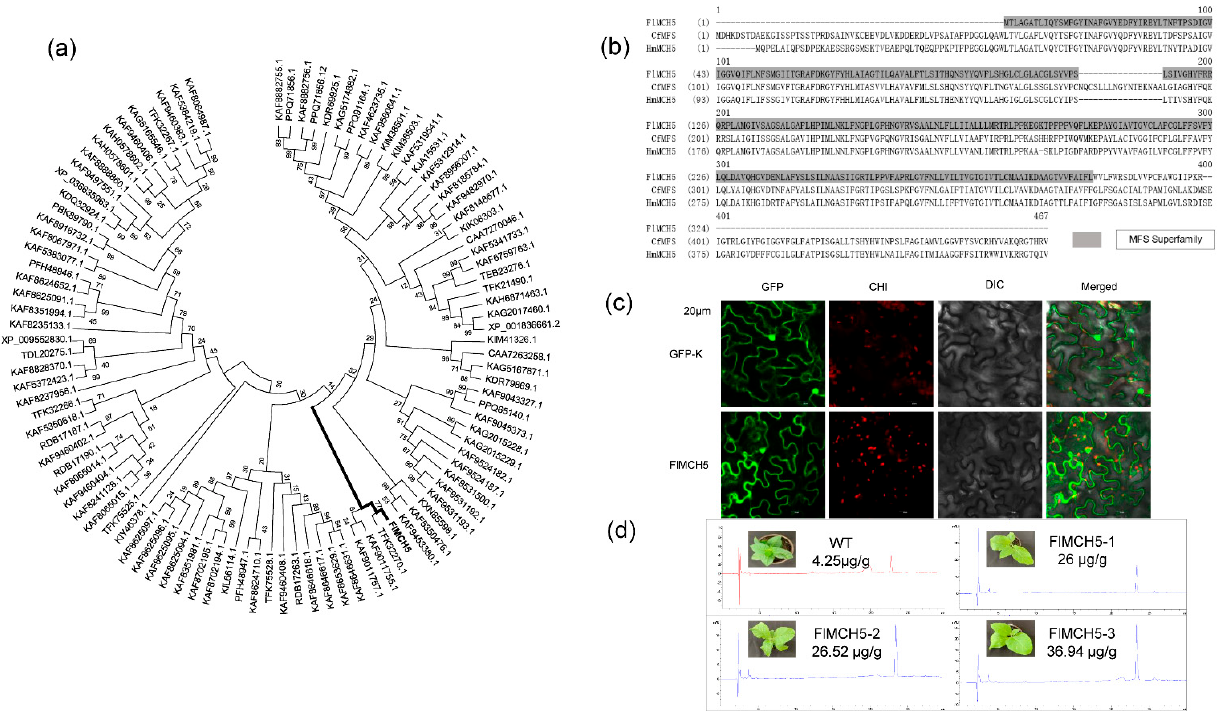
Figure 3. Functional analysis of FlMCH5. ( a ) Phylogenetic tree analysis of FlMCH5. ( b ) FlMCH5 structural–functional domain comparison, where gray represents MFS superfamily. ( c ) The expression of GUS protein negative control and FlMCH5-GUS in tobacco cells; the cell size in the picture is 20 μ m. ( d ) Riboflavin was extracted from transgenic tobacco leaves; the content of riboflavin was determined to be 3 g in leaves.